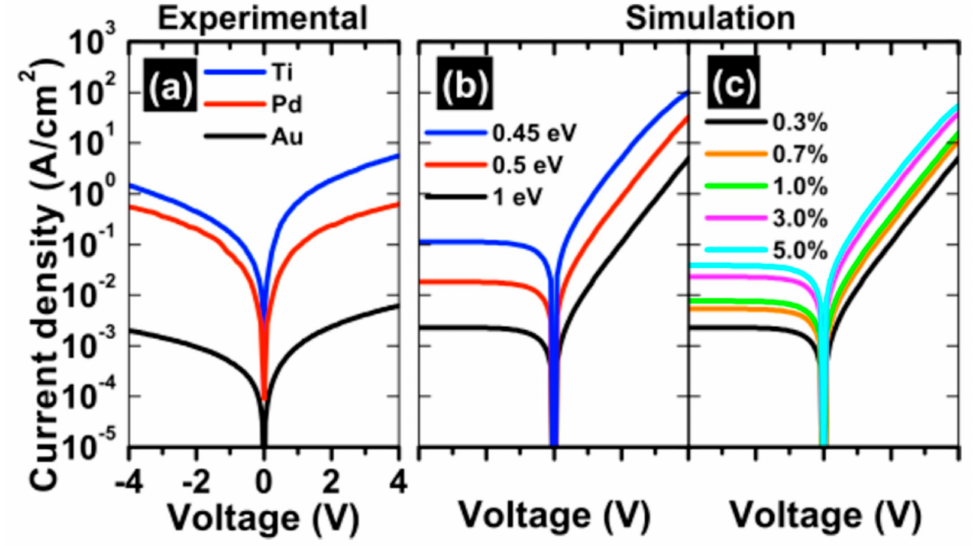
Figure 2. Comparison of the experimental and simulated IV characteristics. ( a ) Experimental current-voltage characteristics of Ti-MoS 2 , Pd-MoS 2 , and Au-MoS 2 for comparison to the simulated curves ( b , c ). ( b ) Simulated IV characteristics for an inhomogeneous interface assuming fixed defect areal density of 0.3% with metal electron Schottky barriers of 0.45, 0.5, and 1 eV. ( c ) Fixed metal electron Schottky barrier of 1 eV and varying defect areal density of 0.3, 0.7, 1, 3, and 5%. Both ( b ) and ( c ) assume the defect electron Schottky barrier to be 0.4 eV and series resistance of 25 Ω . Reprinted with